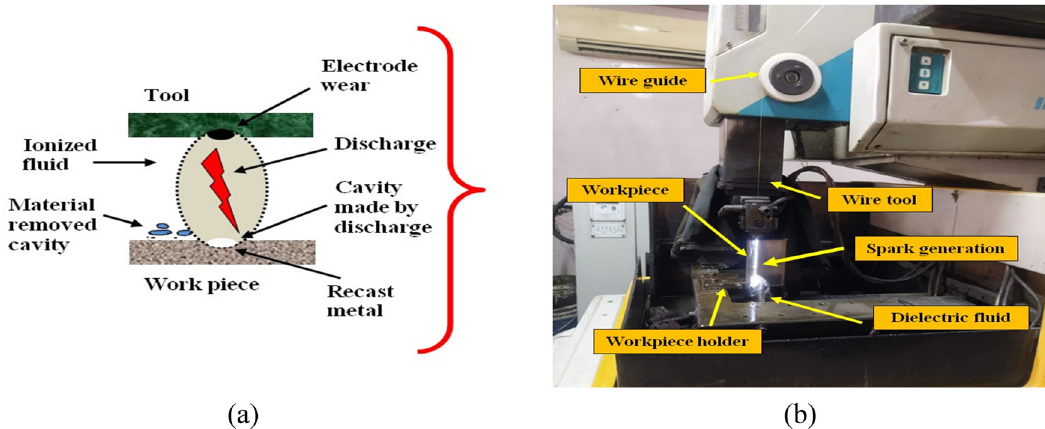
Figure 1: Process mechanism for removing material: ( a ) schematic and ( b ) pictorial